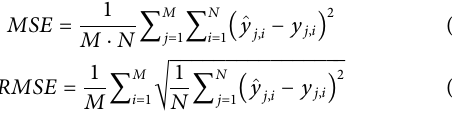
The speci fi c training process is as follows (Figure 3): Step 1: Obtain the initial training dataset and initialize the model parameters.